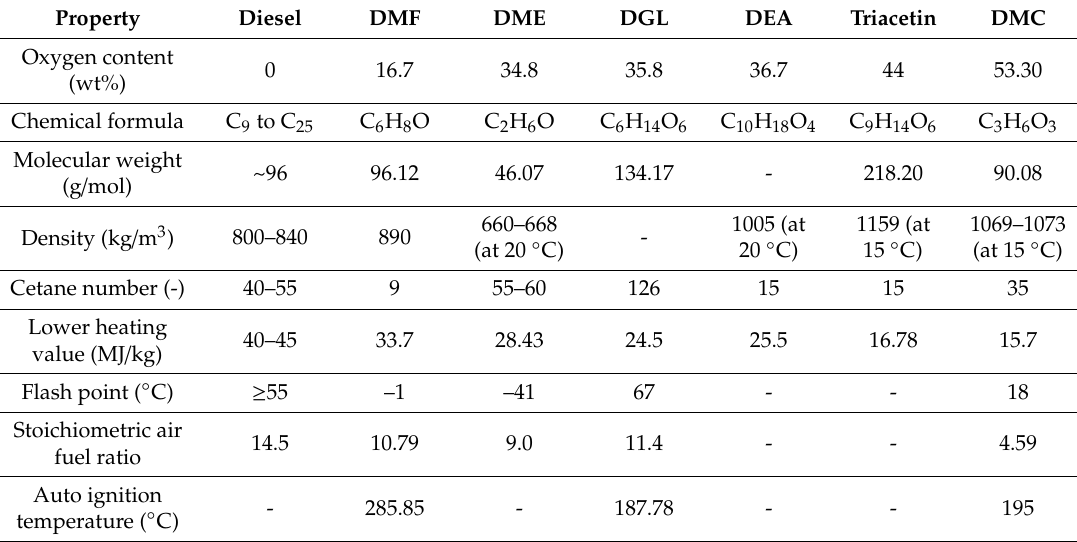
Table 3. Properties of di ff erent oxygenated additives